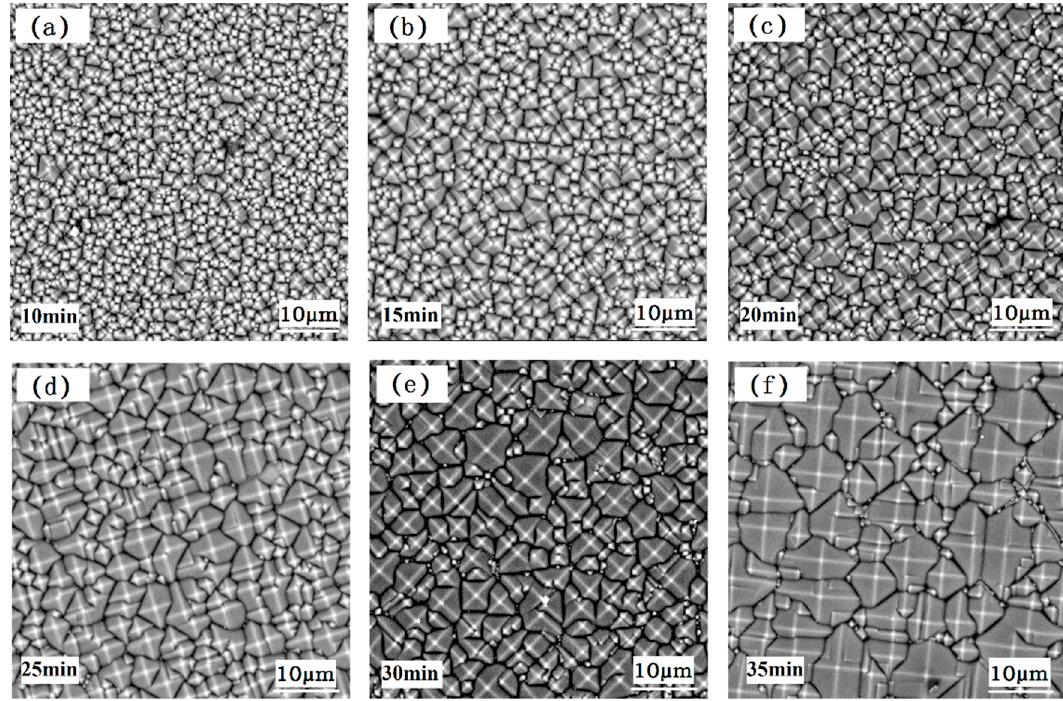
Figure 4. Surface morphology of the wafers: ( a ) Etching for 10 min, ( b ) etching for 15 min, ( c ) etching for 20 min, ( d ) etching for 25 min, ( e ) etching for 30 min, and ( f ) etching for 35 min.